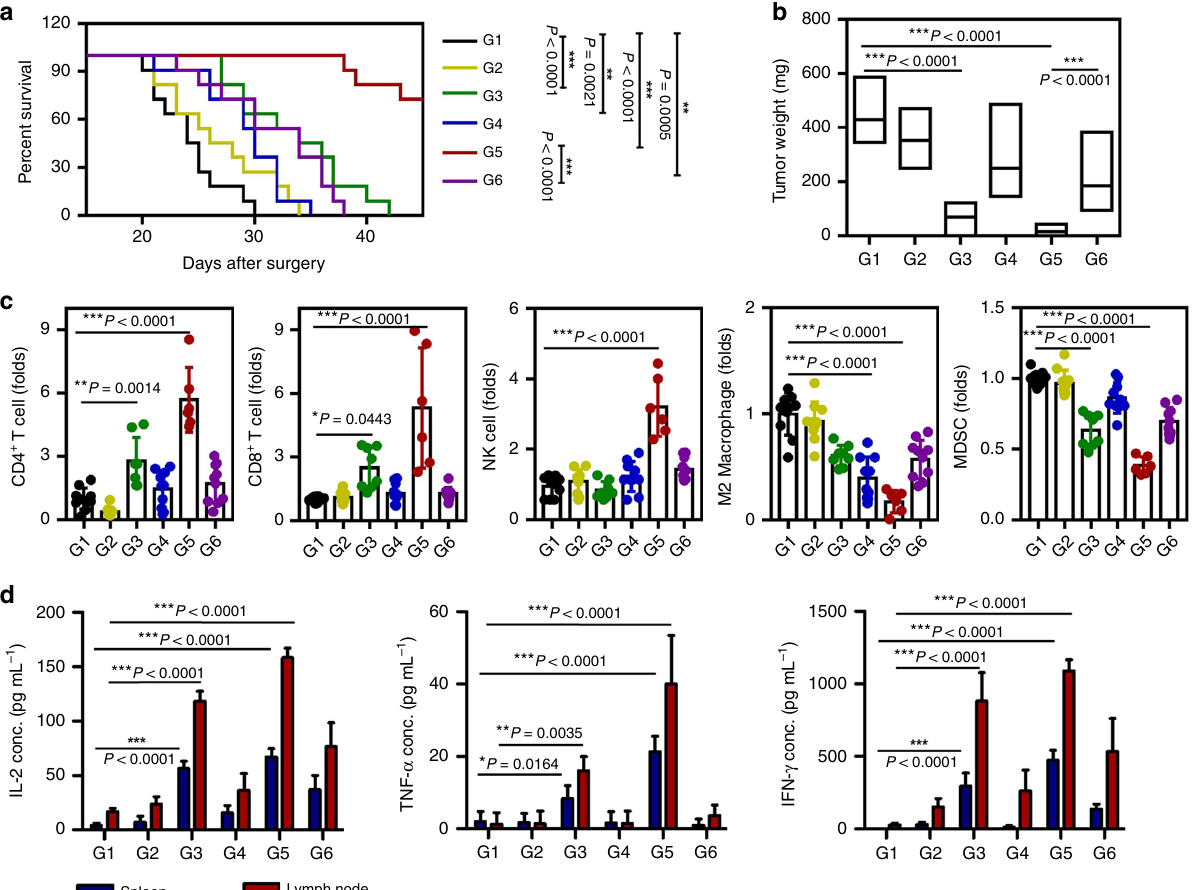
Fig. 4 Antitumor effects of syringeable iGel in post surgical 4T1 tumor models. Tumors were resected when the tumor reached 300 mm 3 in size and were subsequently treated as follows: G1, surgery only; G2, blank gel; G3, MNDV(GEM/R837)/CNL; G4, blank MNDV/clodronate-CNL; G5, MNDV(GEM/ R837)/clodronate-CNL; and G6, MNDV(GEM/R837)/clodronate-ANL. a Survival rate of mice after treatment. Differences in survival were determined for each group ( n = 11) by the Kaplan – Meier method, and the overall P- value was calculated by the log-rank test. b Recurrent tumor weight ( n = 10). c FACSs analysis demonstrating in fi ltrating CD4 + , CD8 + T cells, NK cells, M2 macrophages, and MDSCs in recurring tumors at day 7 post surgery ( n = 10). d Production of cytokines related to the antigen-speci fi c response in spleen and tumor-draining lymph nodes ( n = 6). Lymphocytes isolated from the spleen and tumor-draining lymph nodes were stimulated with 4T1 tumor antigens for 72 h. After incubation, the supernatants were collected. IL-2, TNF- α , and IFN- γ production was measured by ELISA. Data are presented as the mean ± SD. Statistical signi fi cance was calculated by one-way ANOVA and Tukey ’ s test. Data are each pooled from two independent experiments for b – d . Source data are provided as a Source Data fi